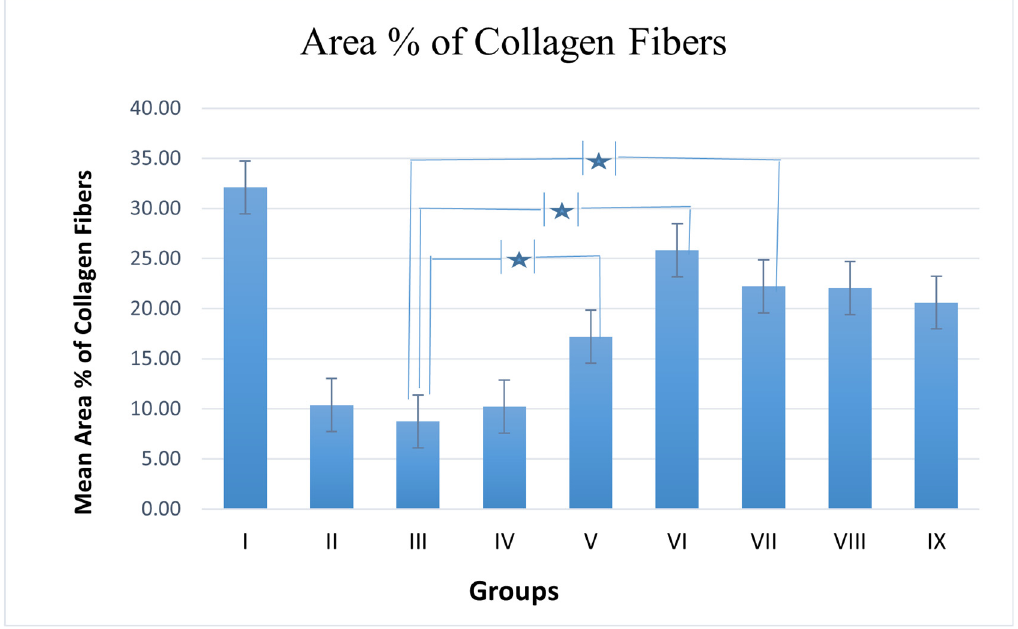
Figure 5 . Mean area % of collagen fibers, data presented as mean positive or negative SE, n = 6. Star: significant difference.